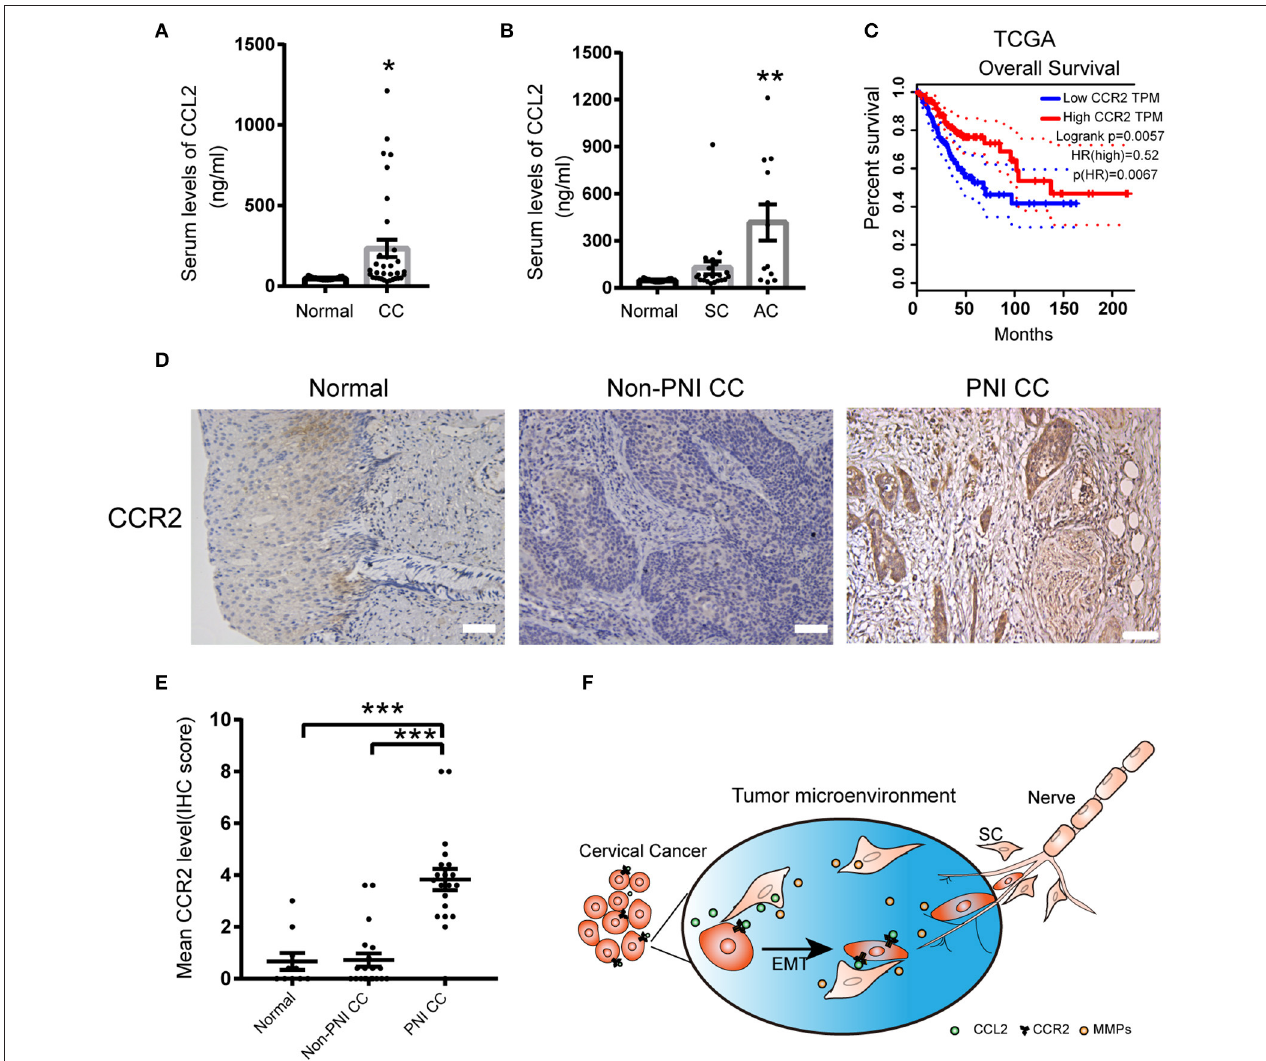
FIGURE 7 | The expression of CCL2 and CCR2 in cervical cancer samples. (A) CCL2 levels in the serum of 15 normal samples and 33 cervical cancer samples detected by ELISA. (B) CCL2 levels in the serum of cervical adenocarcinoma samples upregulated compared to normal samples ( P = 0.0014). (C) Public data shows that CCR2 mRNA expression levels are negatively correlated with the prognosis of cervical cancer ( P = 0.0057). (D,E) CCR2 staining in 20 cervical cancer samples with PNI was stronger than cancer samples without PNI ( n = 20) and normal cervical samples ( n = 16) (200 × magnification, scale bar, 50 µ m). * P < 0.05, ** P < 0.01, *** P < 0.001 compared to the normal group. ns, not significant. (F) Schematic showing the mutual interaction between SCs and cervical cancer